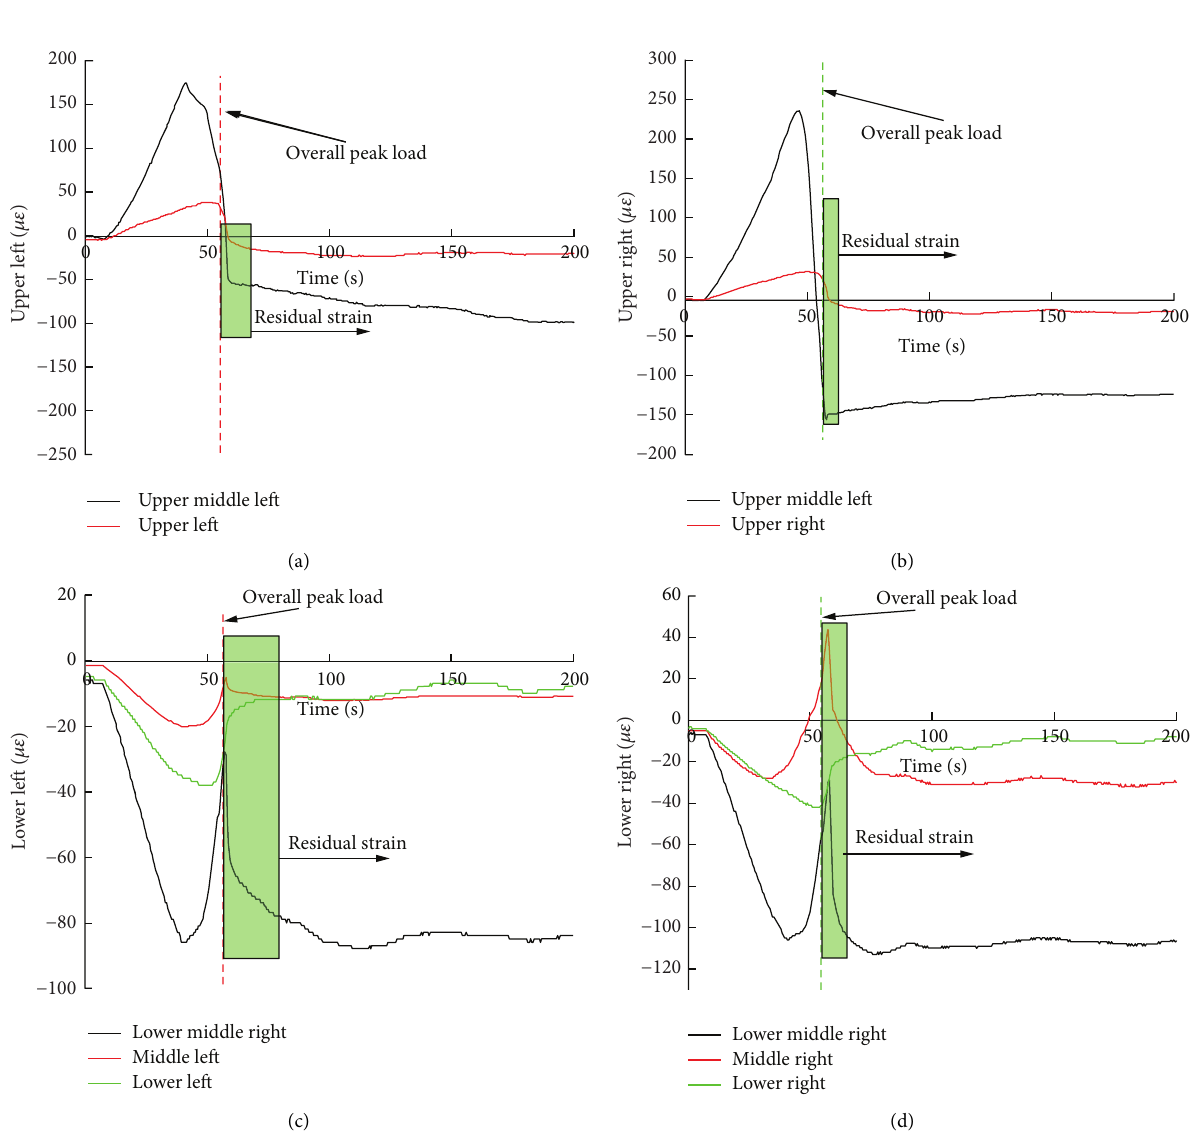
Figure 7: Strain-time curve at characteristic points of specimen S85-2. (a) Upper left area (b) Upper right area. (c) Lower left area. (d) Lower right